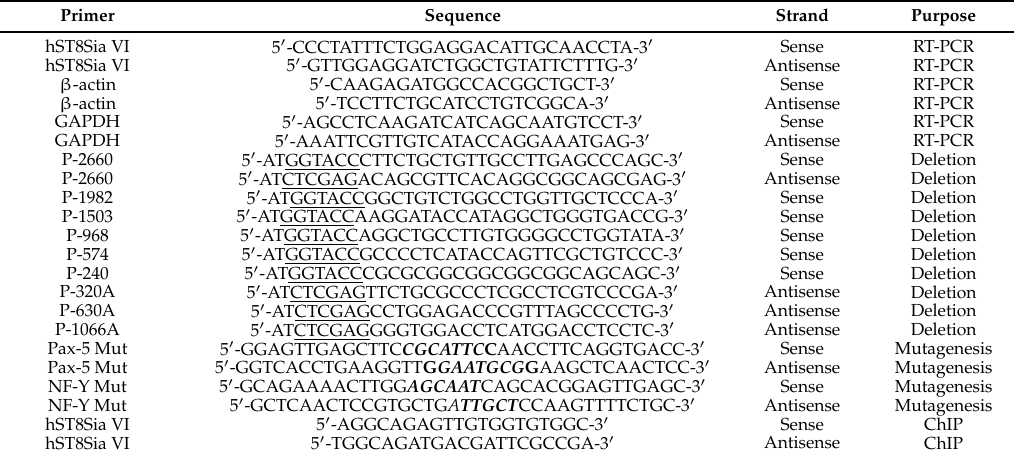
Table 1. Primer sequences used for reverse transcription-polymerase chain reaction (RT-PCR) and deletion constructs, site-directed mutagenesis and chromatin immunoprecipitation (ChIP).